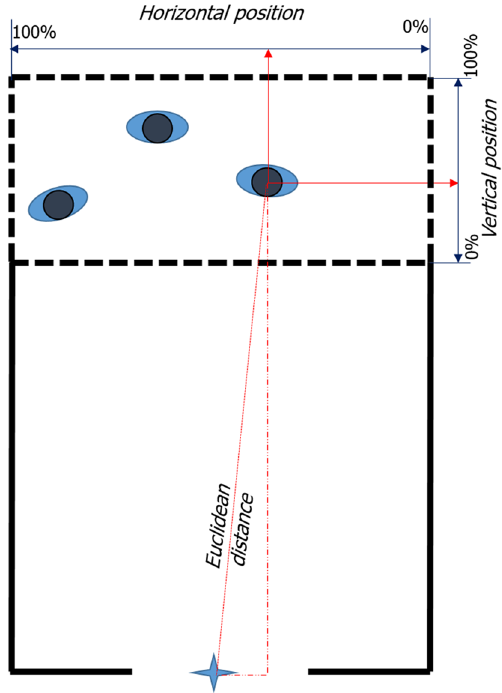
Figure 13. Definition of vertical and horizontal position. The blue star represents the middle point of the exit. Pedestrian stand in the waiting area (dashed area) initially, waiting for the vocal signal to start the experiment. The values of the intersections of solid red lines and light blue axes are the vertical and horizontal positions of the